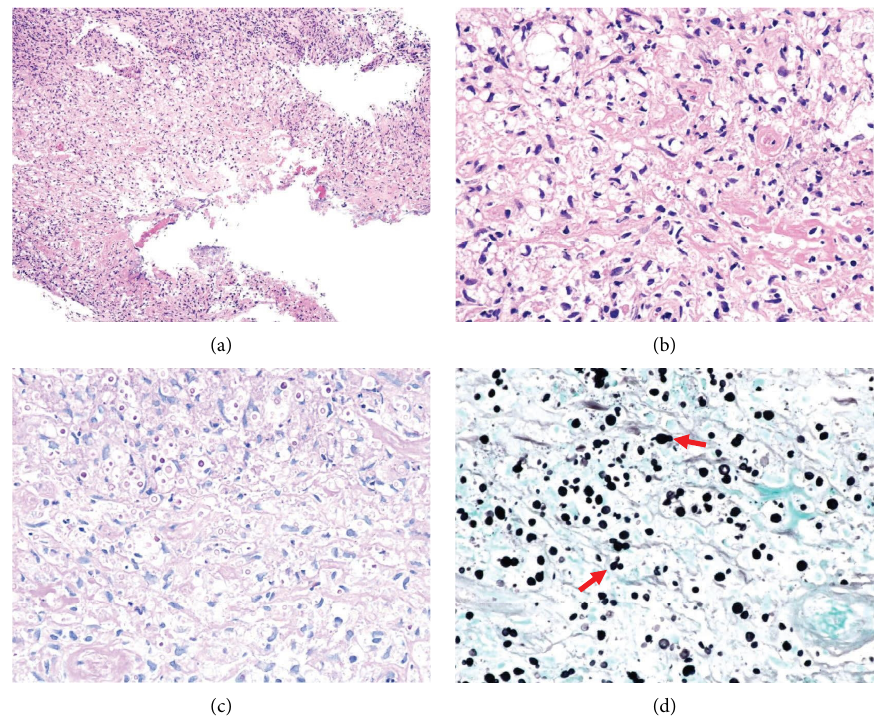
Figure 2: Pathology fndings of biopsy specimens. Hematoxylin-eosin staining showed infammatory cell infltration and spherical structures (a, b). Yeast-type fungi with capsules that tested positive with PAS and Grocott’s staining were observed ((c) PAS staining and (d) Grocott’s staining). Budding yeasts ( ← ) were also observed.